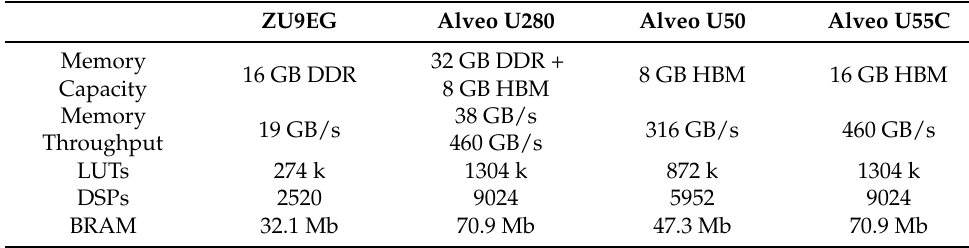
Table 1. Platform FPGA